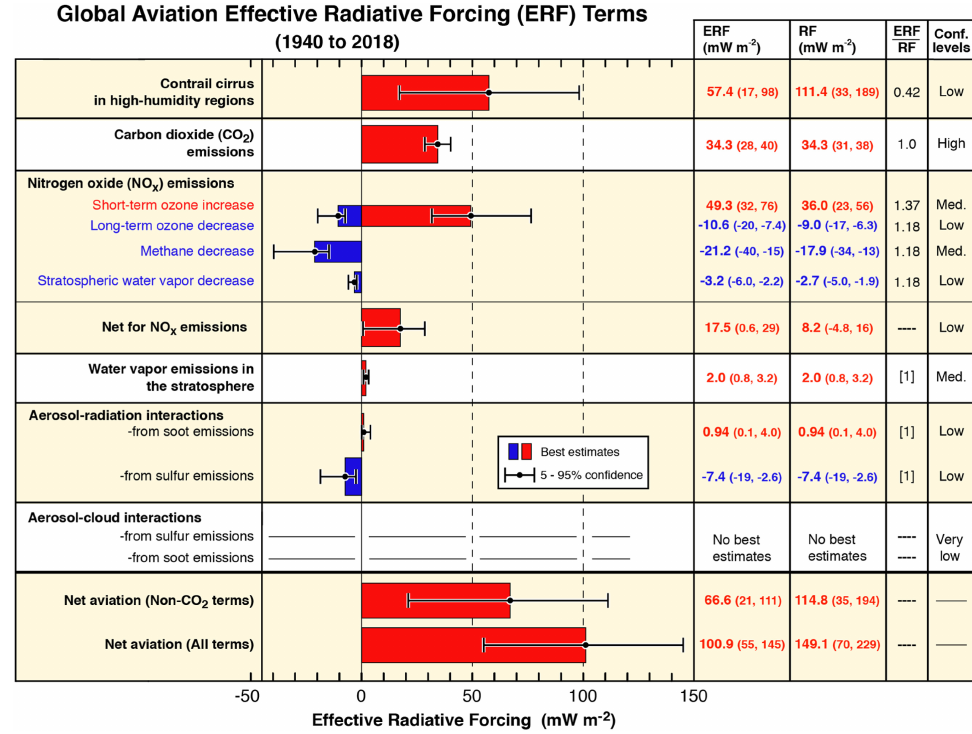
Figure 10. RF contributions from global aviation between 2000 and 2018. Error bars represent 5–95% confidence interval, with corresponding error bounds shown in parentheses. Reprinted with permission from Lee et al. [1]. Copyright 2022,